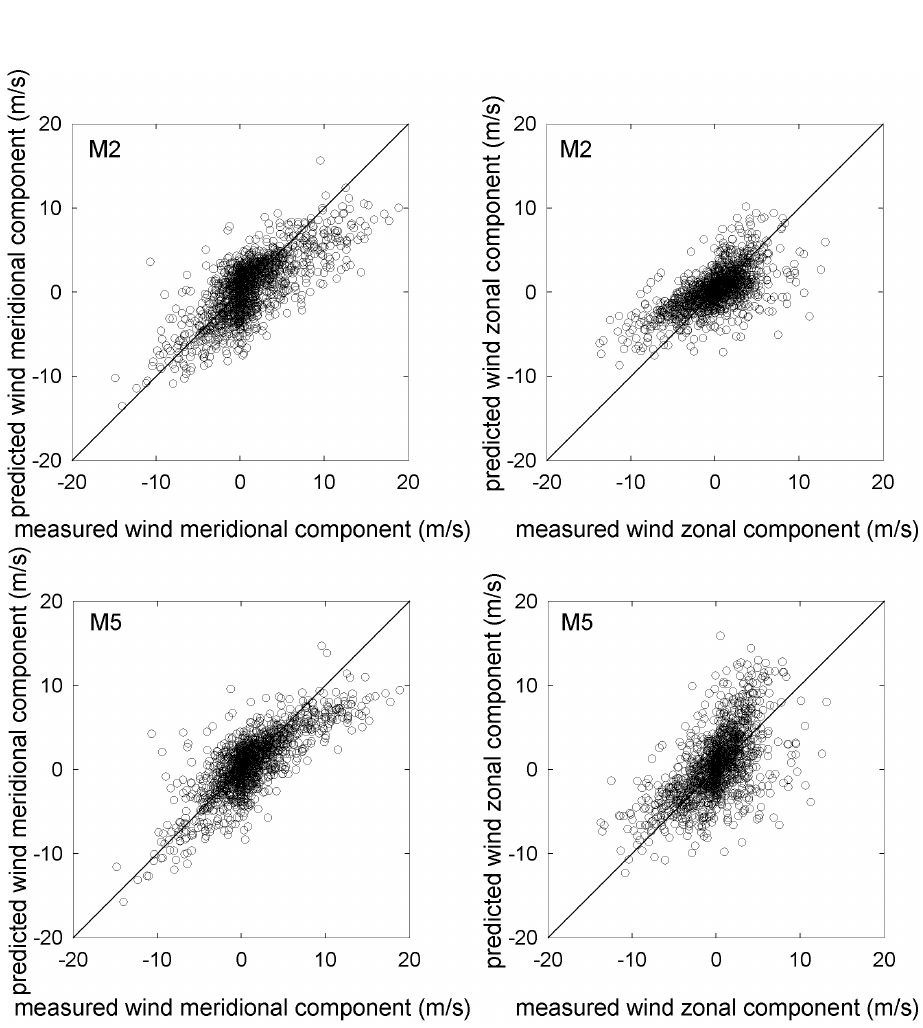
Fig. 14. Polar plots of hourly wind speed components measured from the buoy and predicted by the model in the M2 and M5 grid points.